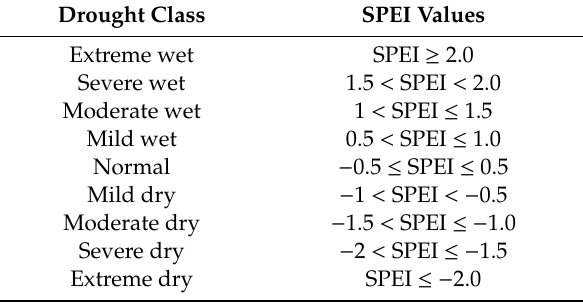
Table 2. Classification used for Standardized Precipitation Evapotranspiration Index (SPEI)